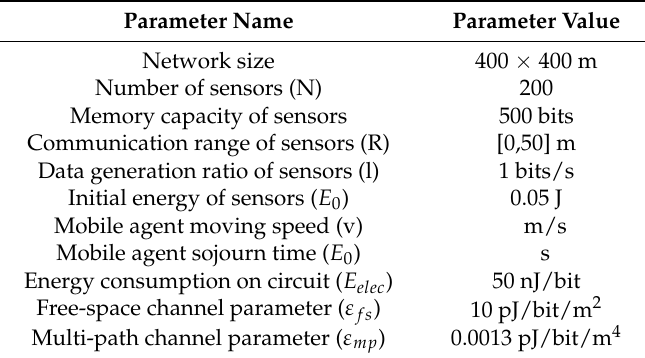
Table 2. Network